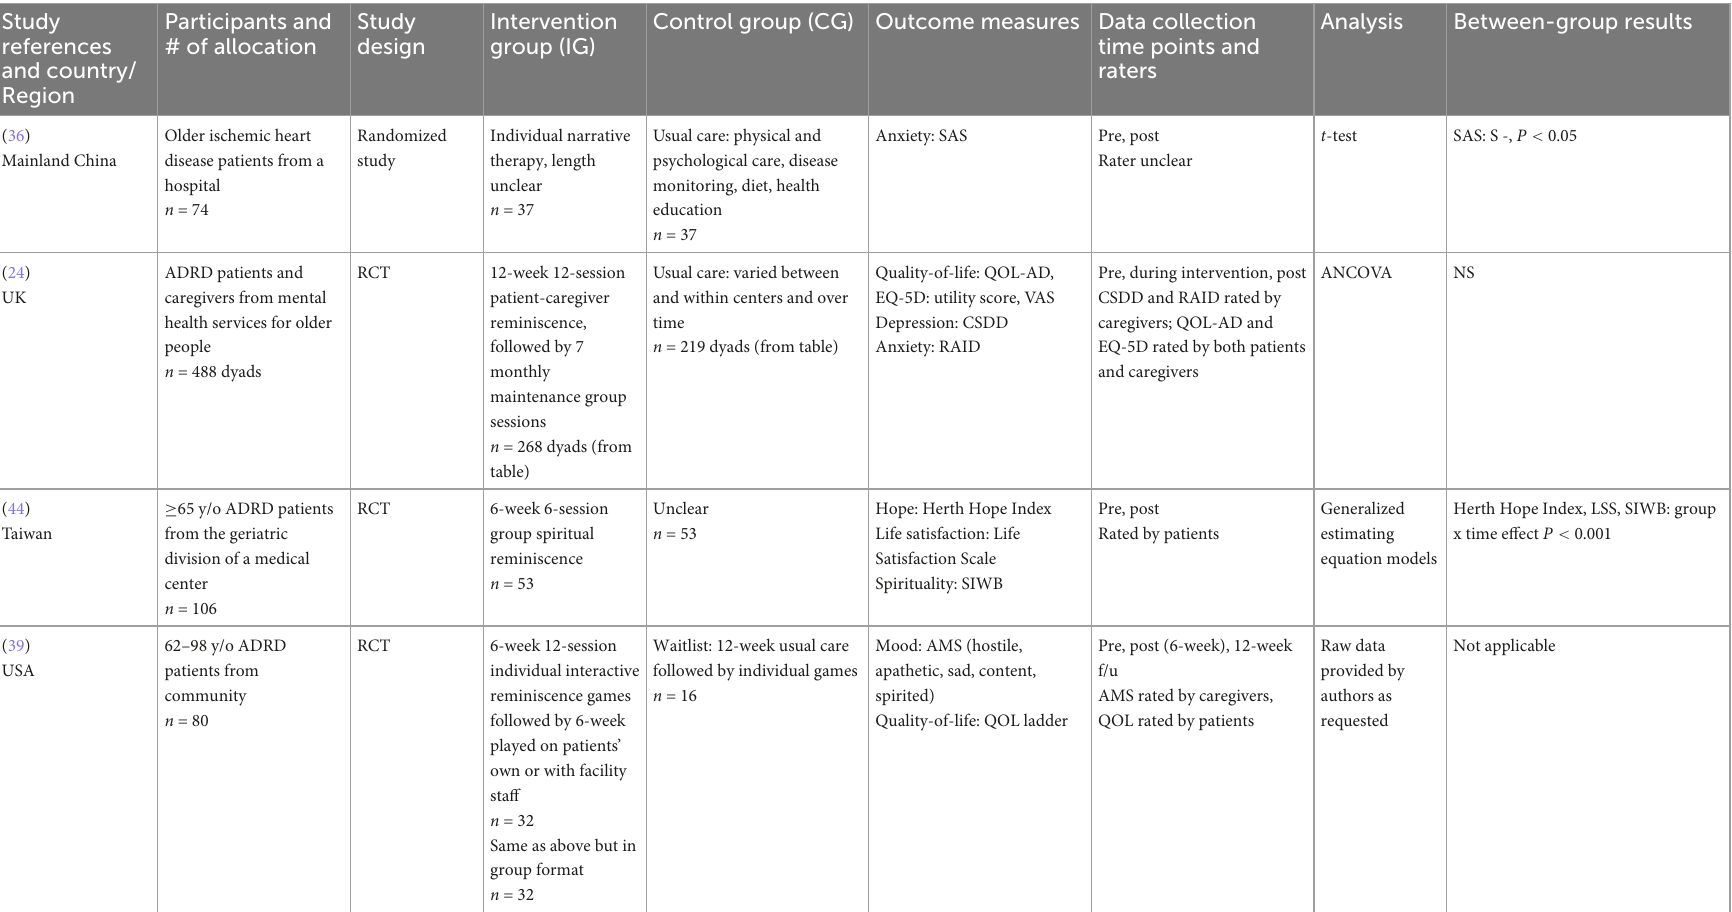
Usual care: varied between and within centers and